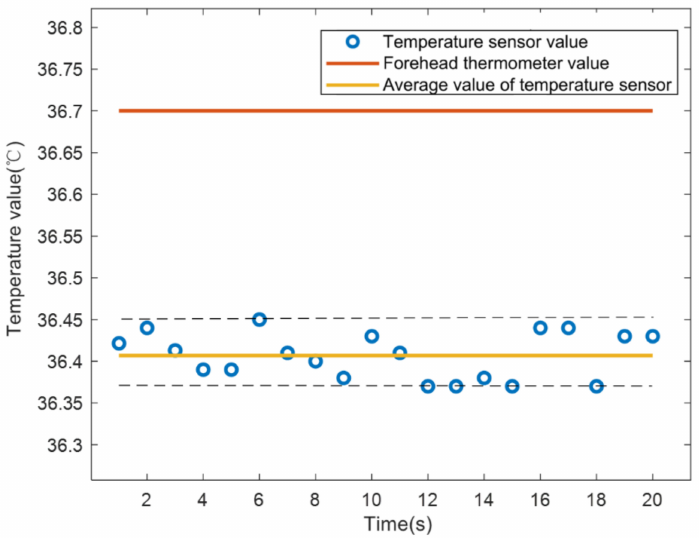
Figure 16. Comparison of temperature measurement between infrared temperature sensor and medical forehead